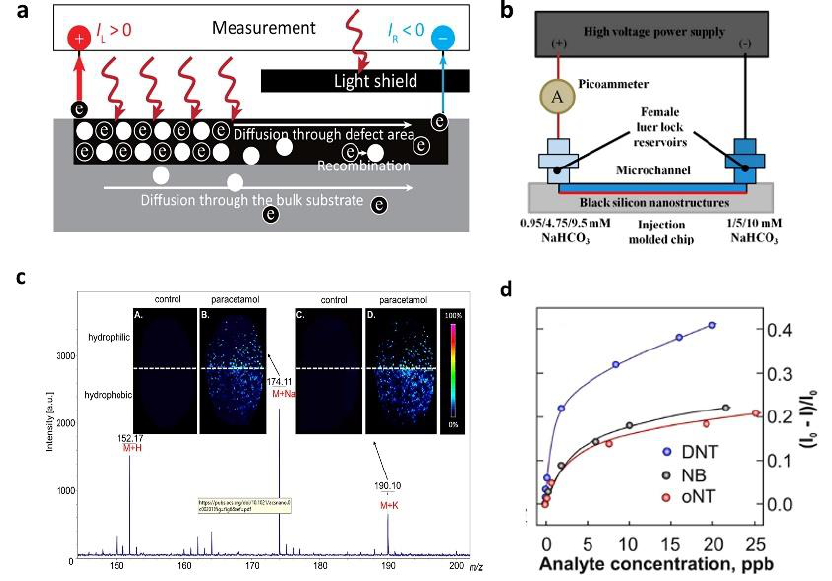
Figure 13. Serval applications based on black silicon in sensing. ( a ) Structure of ammonia sensor using b-Si material to realize ultrahigh Sensitivity. Adapted from reference [108], with permission from American Chemical Society © 2020. ( b ) Experimental setup for black silicon nanostructures current monitoring. Adapted from reference [109], with permission from Royal Society of Chemistry © 2020. ( c ) Using black silicon to achieve surface-assisted laser desorption/ionization mass spec- trometry imaging. Adapted from reference [110], with permission from American Chemical Soci- ety© 2020. ( d ) Evaluate detection limits of cbz-bSi gas sensor. Adapted from reference [111], with permission from American Chemical Society© 2020.